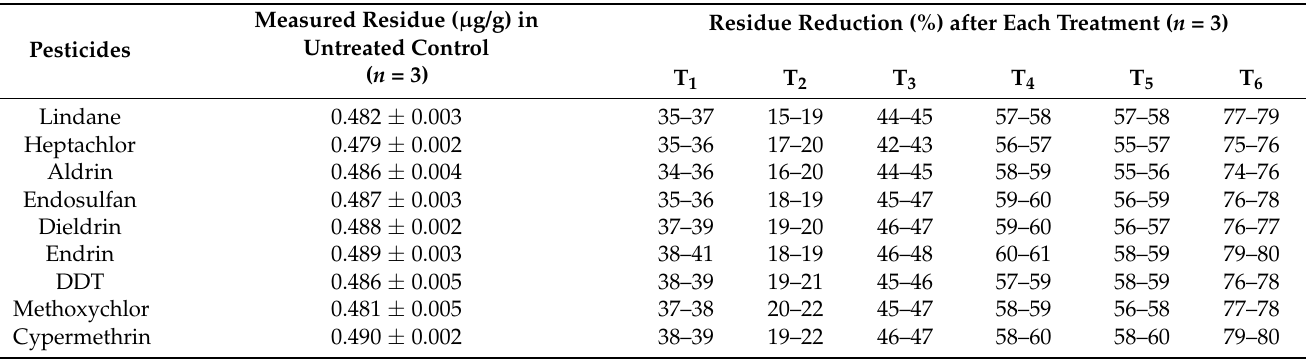
Table 5. Reduction in pesticide residues (%) in Anabus testudineus by the six household treatments.